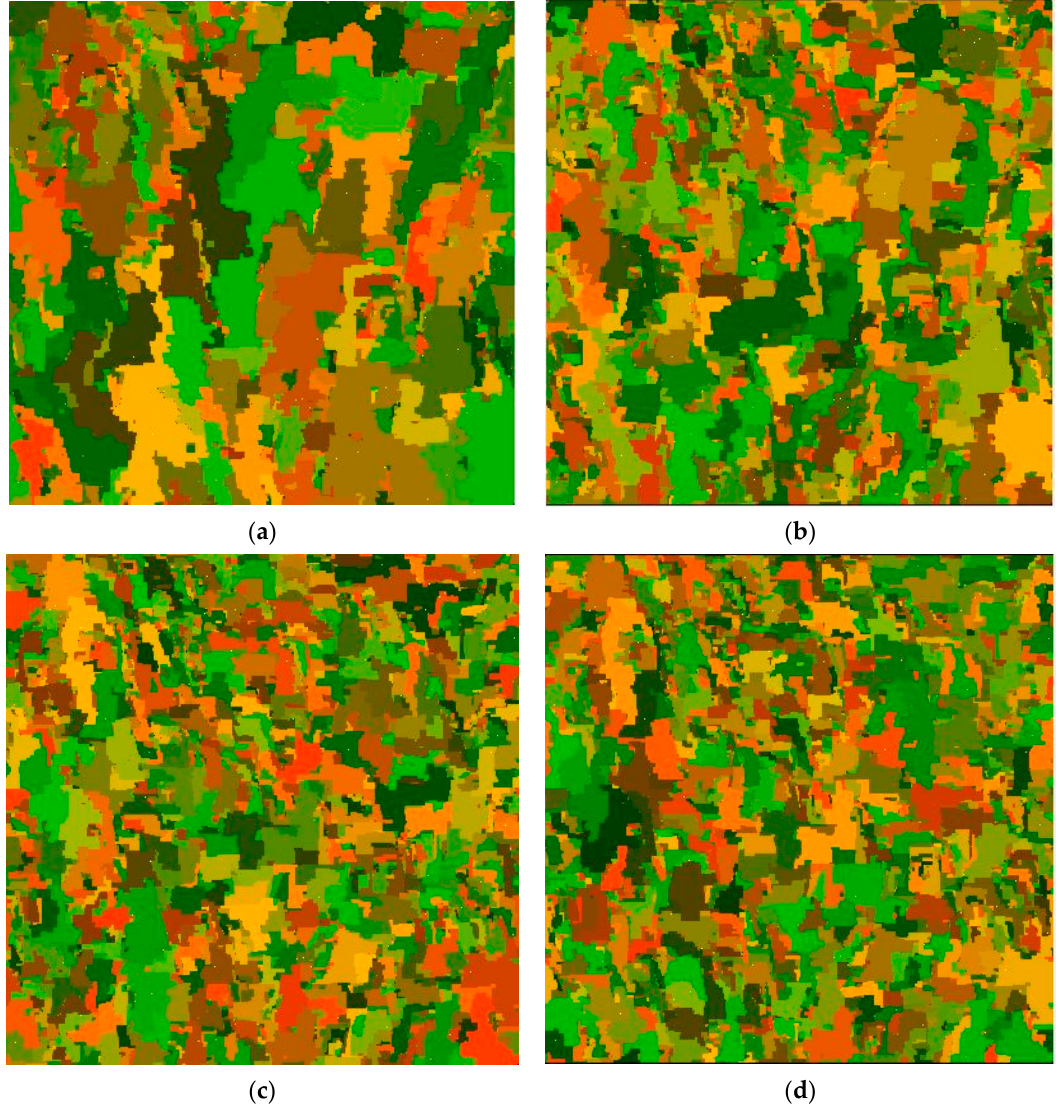
Figure 7. ( a – d ) Two-dimensional maps ( D = 2, L = 5000) illustrating the dynamics of the magnetization process for various values of the external field step ∆ H = {0.1, 0.01, 0.001, 0.0001}. Single-colored areas represent spins that were flipped due to avalanche interactions in metastable conditions.